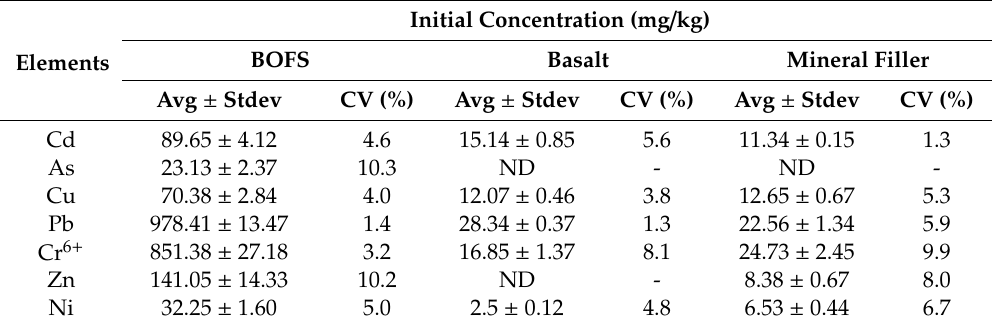
Table 3. Initial Concentration of heavy metals (HMs) of BOFS, basalt and mineral filler.